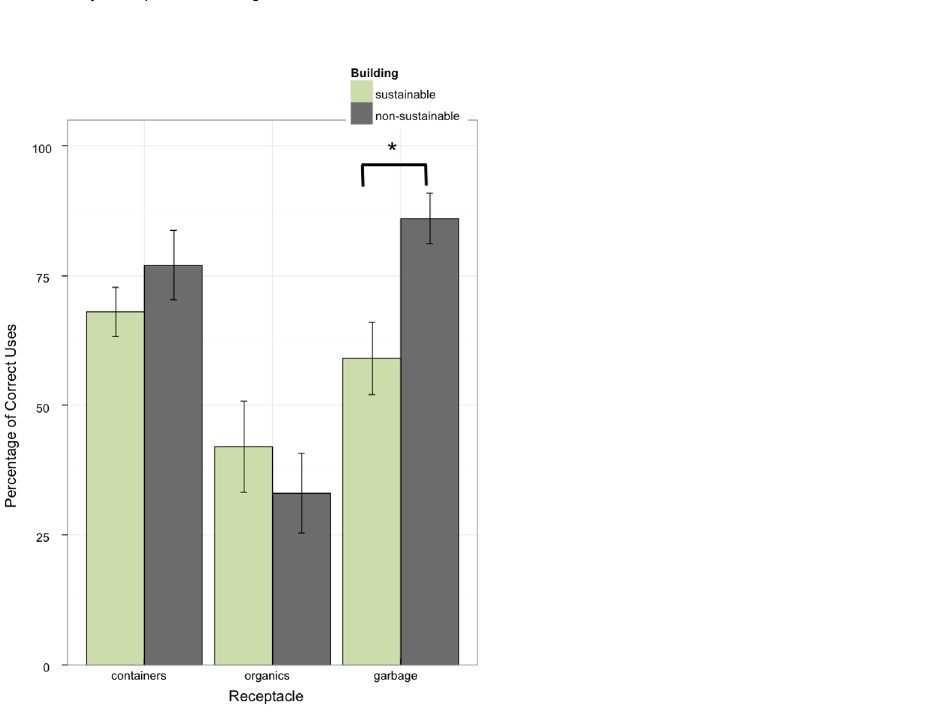
Fig 4. The number of times containers, organics, and garbage receptacles were selected in a sustainable building versus a non-sustainable building. Participants in the sustainable building condition used the garbage receptacle less than those in the non-sustainable building. As noted by the asterisk this difference was significant between the buildings.